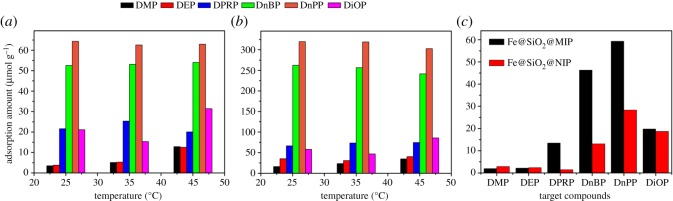
The selective adsorption of six PAEs by Fe@SiO2@MIP at different temperatures ((a) initial concentration 2 mg l−1, (b) initial concentration 10 mg l−1) and the competitive adsorption of six PAEs by Fe@SiO2@MIP and Fe@SiO2@NIP at 25°C (c).